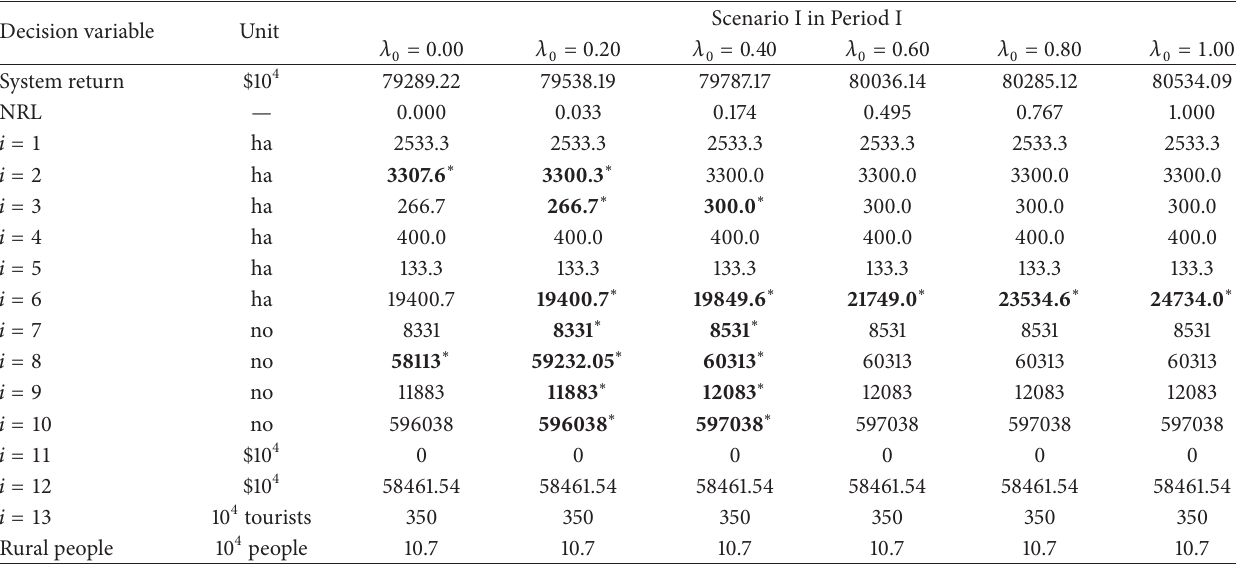
Table 4: Risk explicit analysis in Period I under Scenario